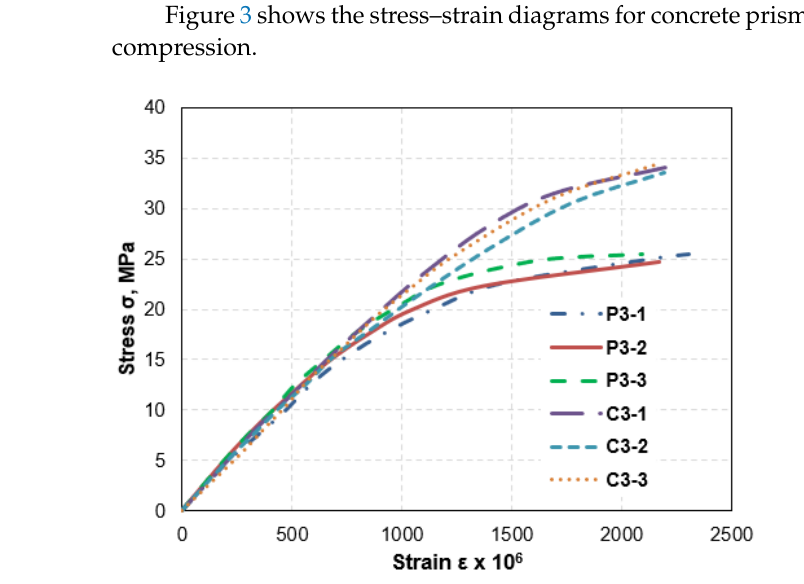
Figure 3. Stress–strain diagrams for concrete prisms (P3-1, P3-2, and P3-3) and cubes (C3-1, C3-2, and C3-3) under uniaxial compression.